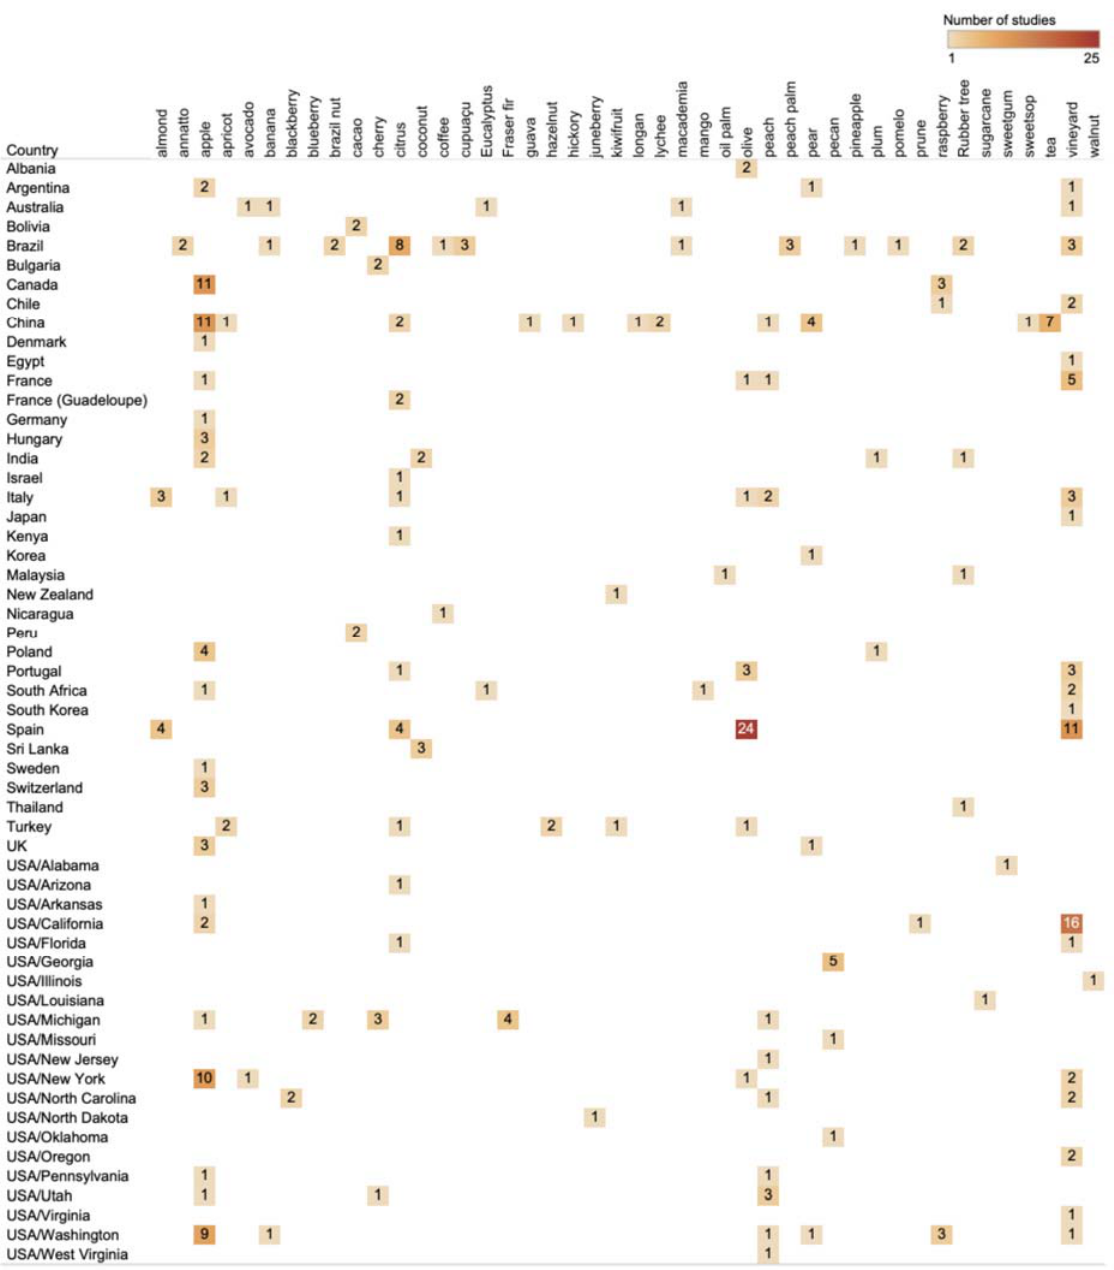
Figure 3. Distribution of cover crop research, by perennial system, distinguished by country. Due to the high quantity of research conducted in the USA, research is presented by state for that country. The research distribution amongst perennial crops reveals distinct interests and priorities divided by country, which likely reflect different socio ‐ economic contexts and bio ‐ zones. The non ‐ randomized distribution of cover crop research, distinct to different countries, reveals the contextualization of cover crop knowledge. It is important to note that due to our definition of cover cropping, which included only seeded or covers with identified plant species, many published cover crop studies were excluded from our analysis.